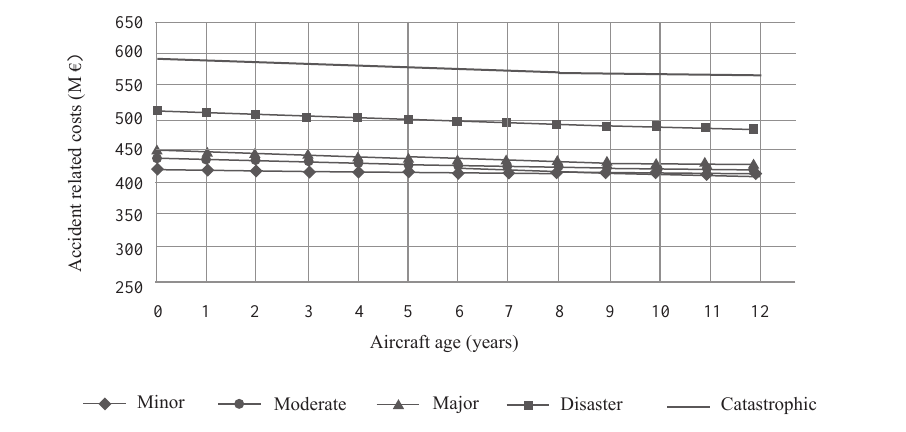
Fig. 4. Max total accident related costs as a function of aircraft age and accident severity